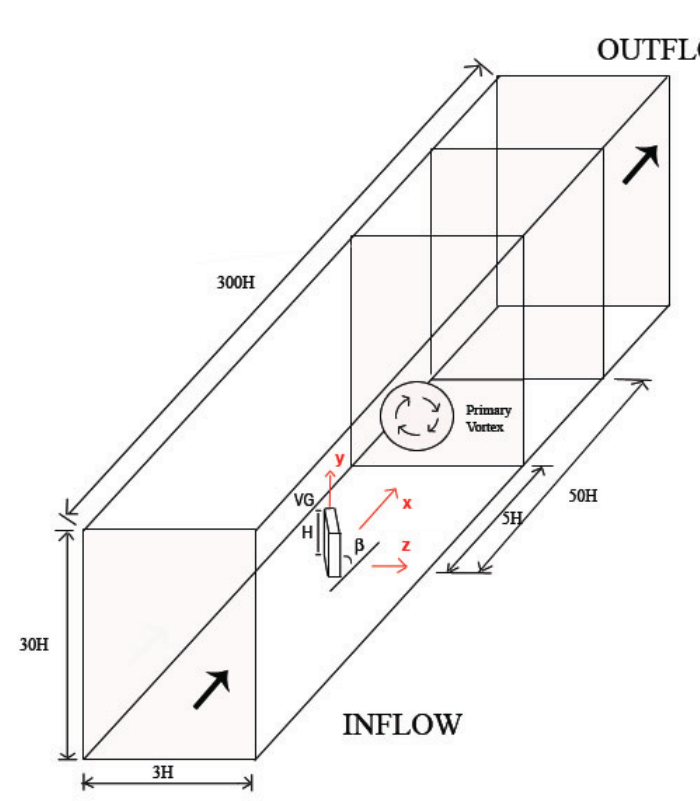
Figure 3. Computational domain dimensions normalized respect to H.